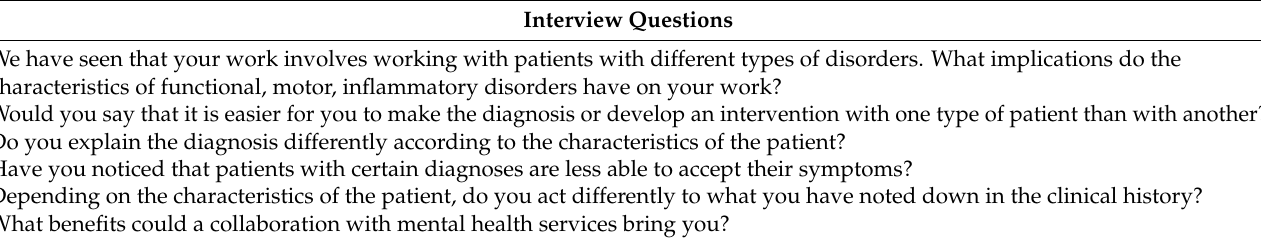
Table 1. A summary of the physicians’ interview questions.